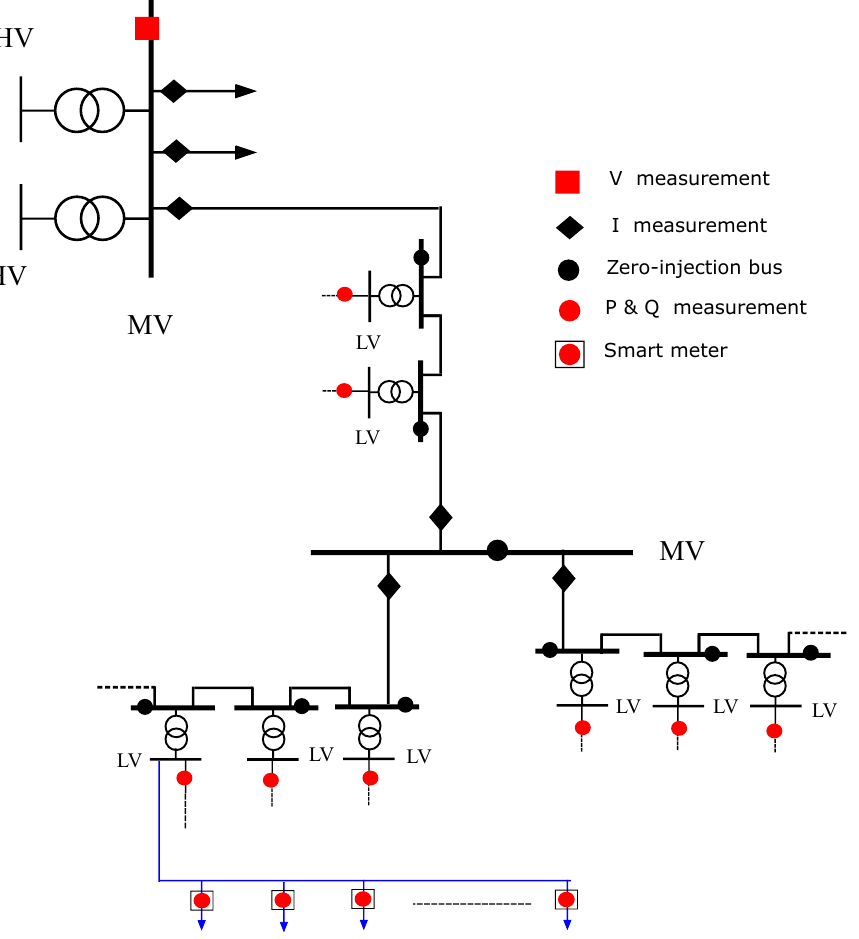
Figure 1. One-line diagram of a typical European MV